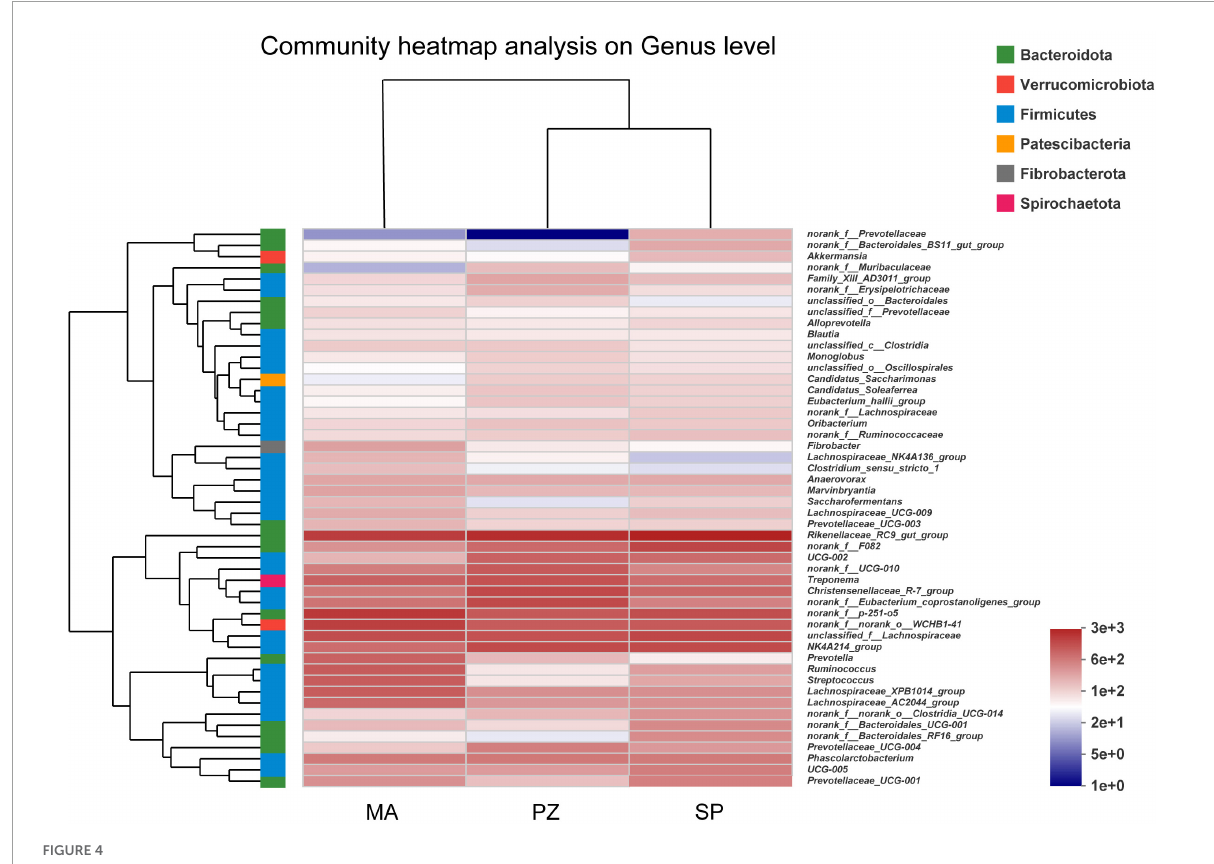
FIGURE4 Heatmap of intestinal bacterial community